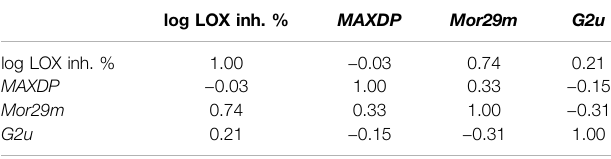
TABLE 5 | Correlation matrix between descriptors included in model (1).